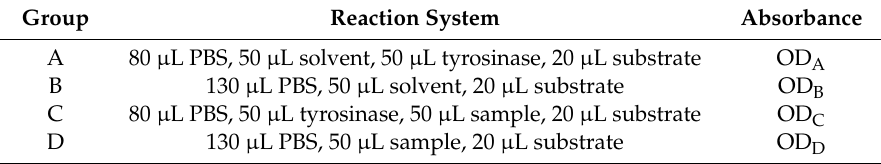
Table 2. Specific grouping and reaction system for tyrosinase inhibitory activity.